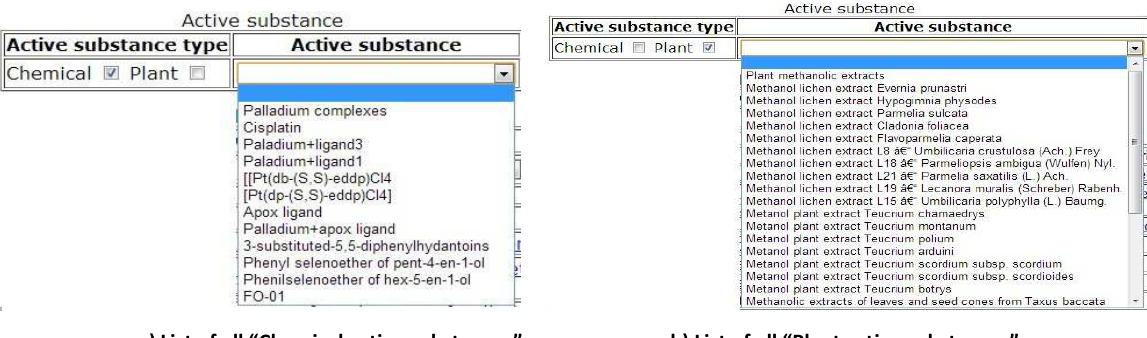
Figure 11. Active substance